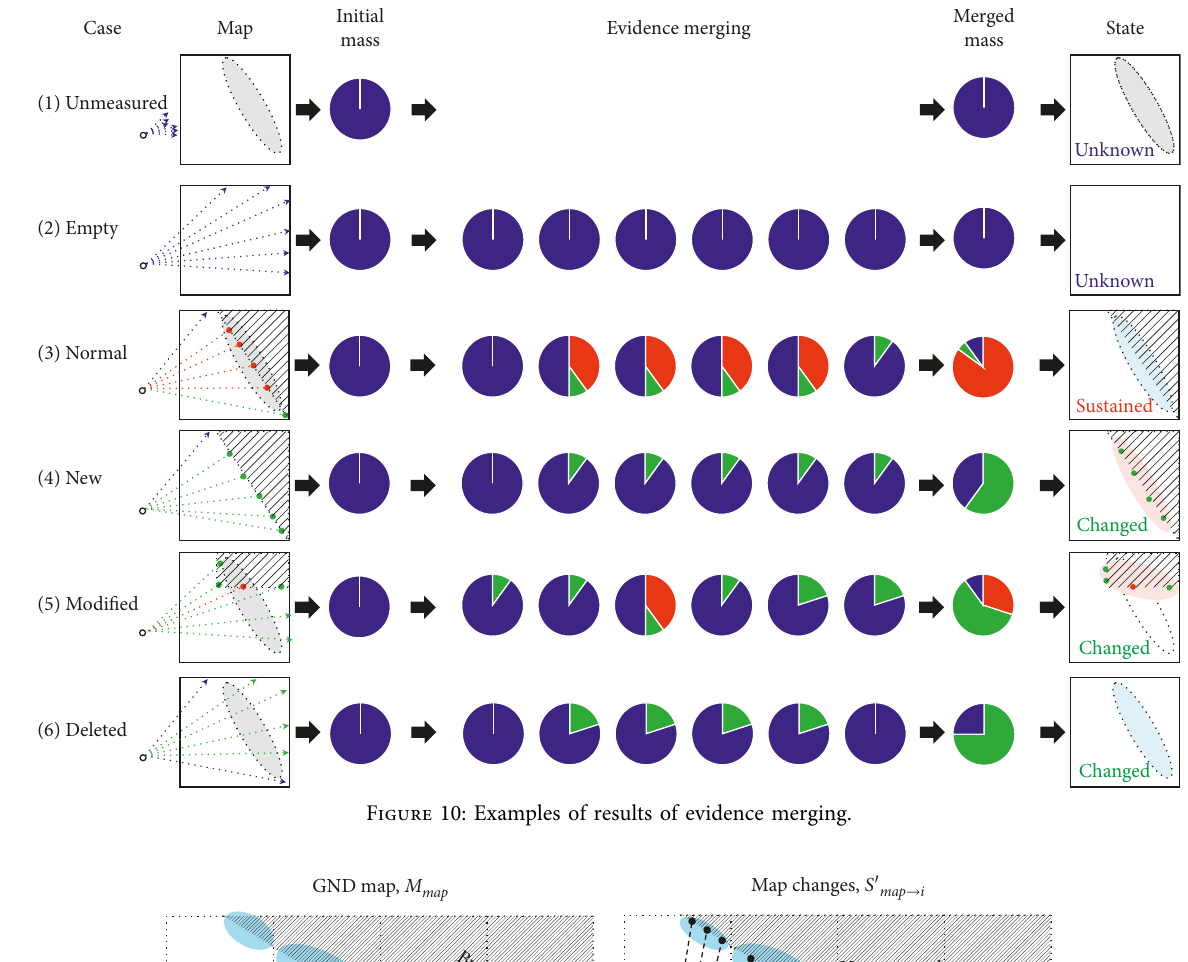
Figure 10: Examples of results of evidence